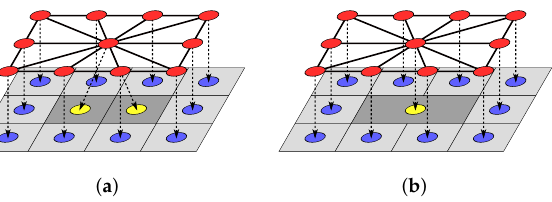
Figure 8. Union on pixel clusters, showing features before and after operation. ( a ) Pixel clusters before merge operation; ( b ) Pixel cluster after union operation After all the pixel clusters smaller than c min have been merged, a second loop